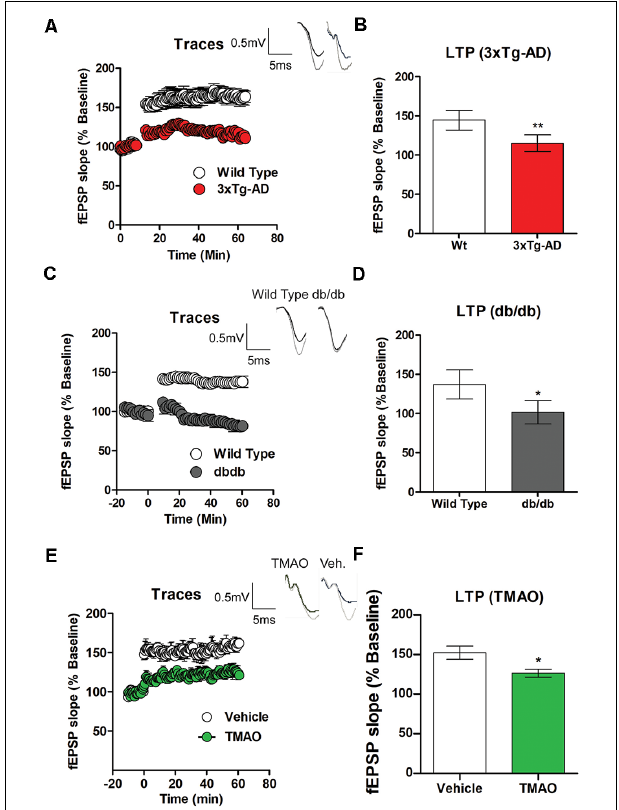
FIGURE 2 | Deficits in long term potentiation (LTP) are noted in 3 × Tg-AD and db/db mice. Hippocampal slices from control, 3 × Tg-AD, and db/db mice were incubated for 2 h in artificial cerebral spinal fluid (ACSF) before recording. (A) LTP graph represents field excitatory postsynaptic potential (fEPSP) slope before and after induction by theta burst stimulation (TBS) in control (wild type) and 3 × Tg-AD mice aged 8 months. (B) LTP bar graph shows fEPSPs recorded during the period 50–60 min following TBS induction normalized to baseline levels. (C) LTP graph comparing control (wild-type) and db/db mice aged 8 months and (D) bar graph representing fEPSPs during 50–60 min following TBS induction normalized to baseline levels. Hippocampal slices from control mice were incubated in ACSF with either 0.03% dimethyl sulfoxide (DMSO; vehicle) or TMAO (50 µ M) for 4 h before recording. (E) LTP graph represents fEPSP slope before and after induction by TBS in vehicle-treated and TMAO treated slices. (F) LTP bar graph shows fEPSPs recorded during the period 50–60 min following TBS induction normalized to baseline levels. Bars represent mean ± SEM; *indicates a significant difference between control (wild-type) and db/db or 3 × Tg-AD mice and significant difference between vehicle vs. TMAO treated slices, * p < 0.05 for (A–D) . Results are shown as mean ± SEM of three to four mice per group and * p < 0.05, ** p < 0.01; n = 5–6 slices from four mice per group; for (E,F) n = 5–6 slices from four mice per group.